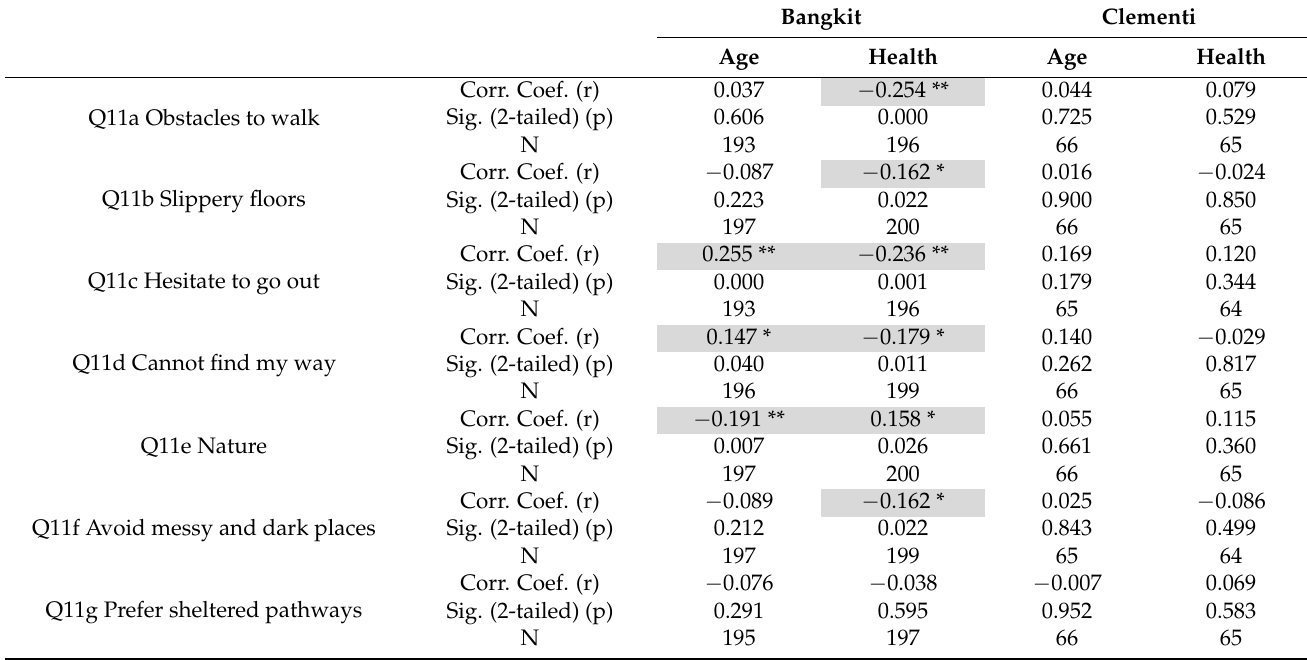
Table 12. Spearman correlation test: correlation between walking experience (Question 11 of Socio-sensory Survey, Appendix A), age and health condition.